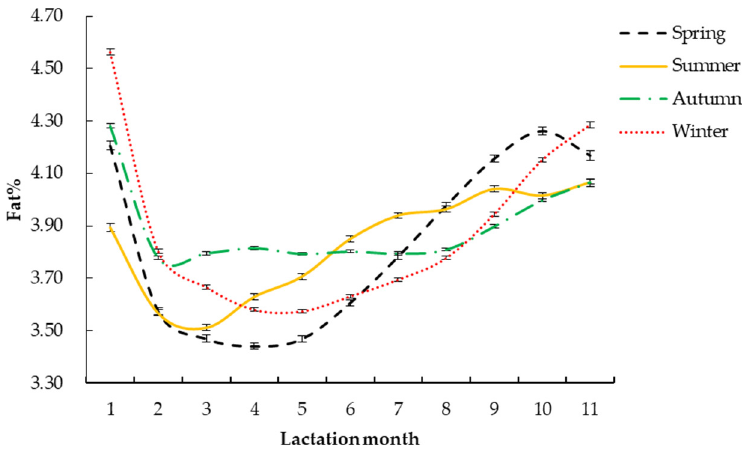
Figure 3. Lactation curves of Wood model for different calving seasons.